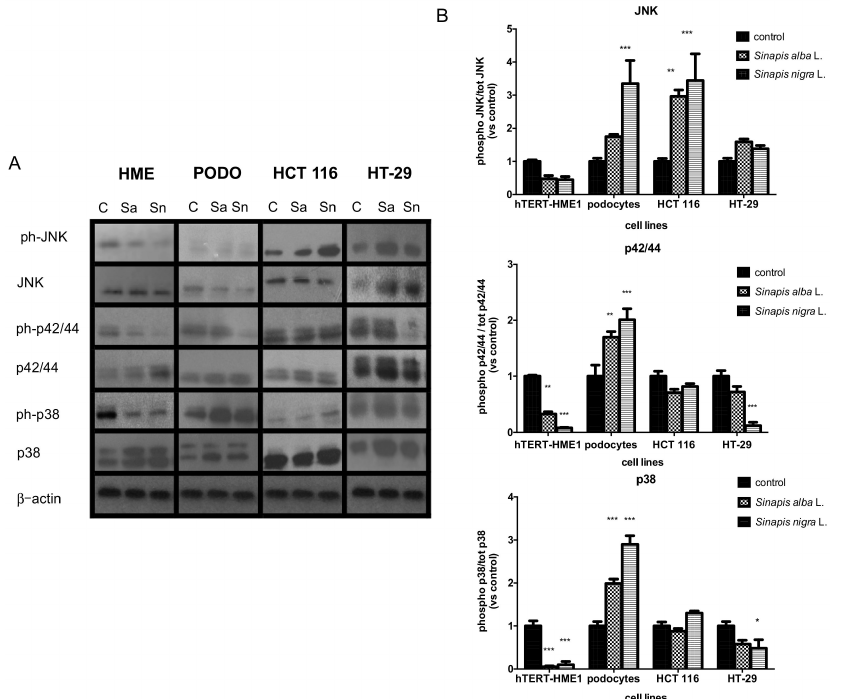
Figure 2. Effect of S. alba (Sa) and S. nigra (Sn) seed ethanolic extracts on the phosphorylation of p38, p42/44 and c-Jun N-terminal kinase (JNK) Mitogen-Activated Protein Kinases (MAPKs) at 30 min of treatment ( A ) Immunoblotting of one representative experiment of the two, at least, was performed. ( B ) Densitometric results, normalized to total protein, expressed in densitometric units with control = 1 [means ± standard error (SE) of at least two separate